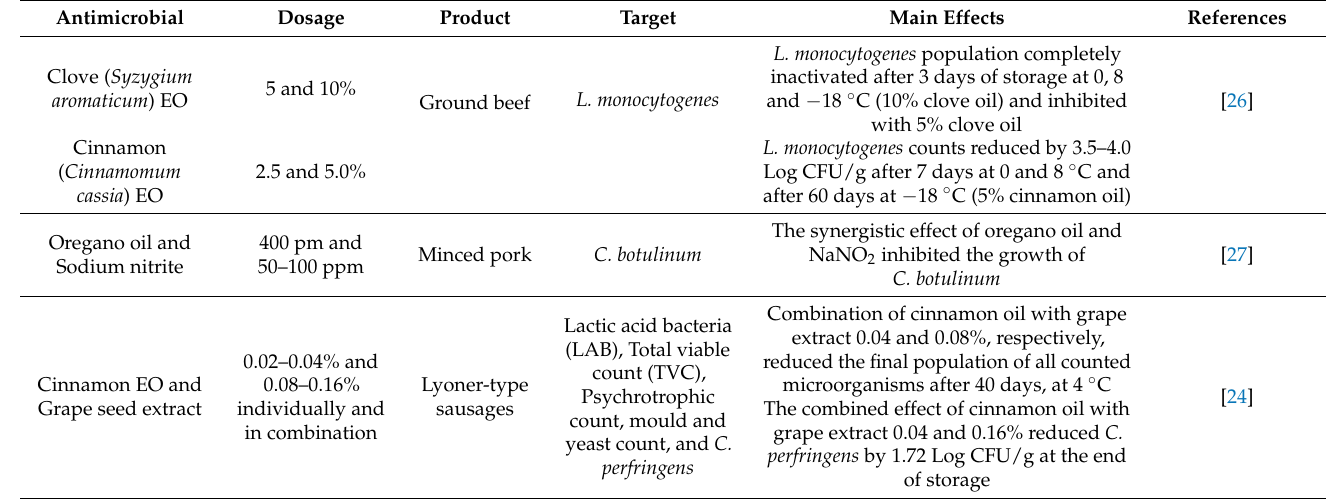
Table 2. Studies on the application of clean-label antimicrobial compounds on meat products.